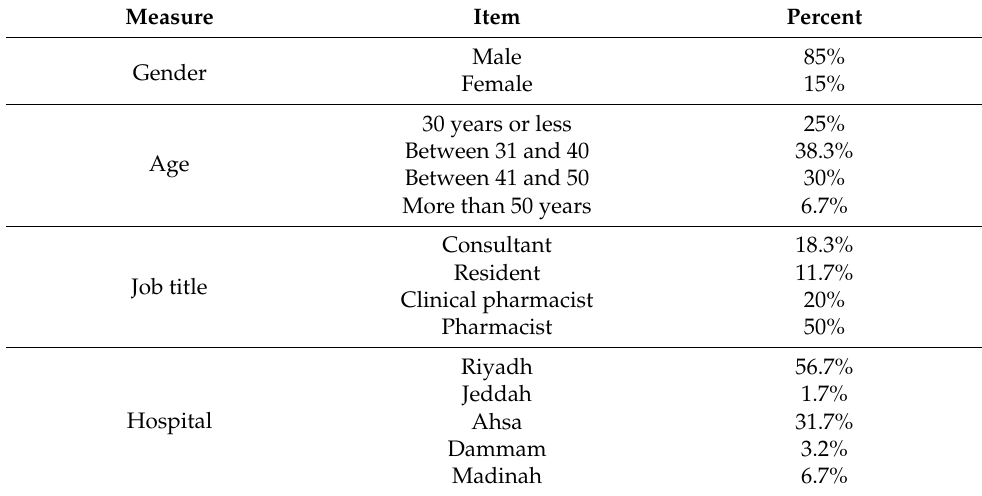
Table 1. Descriptive